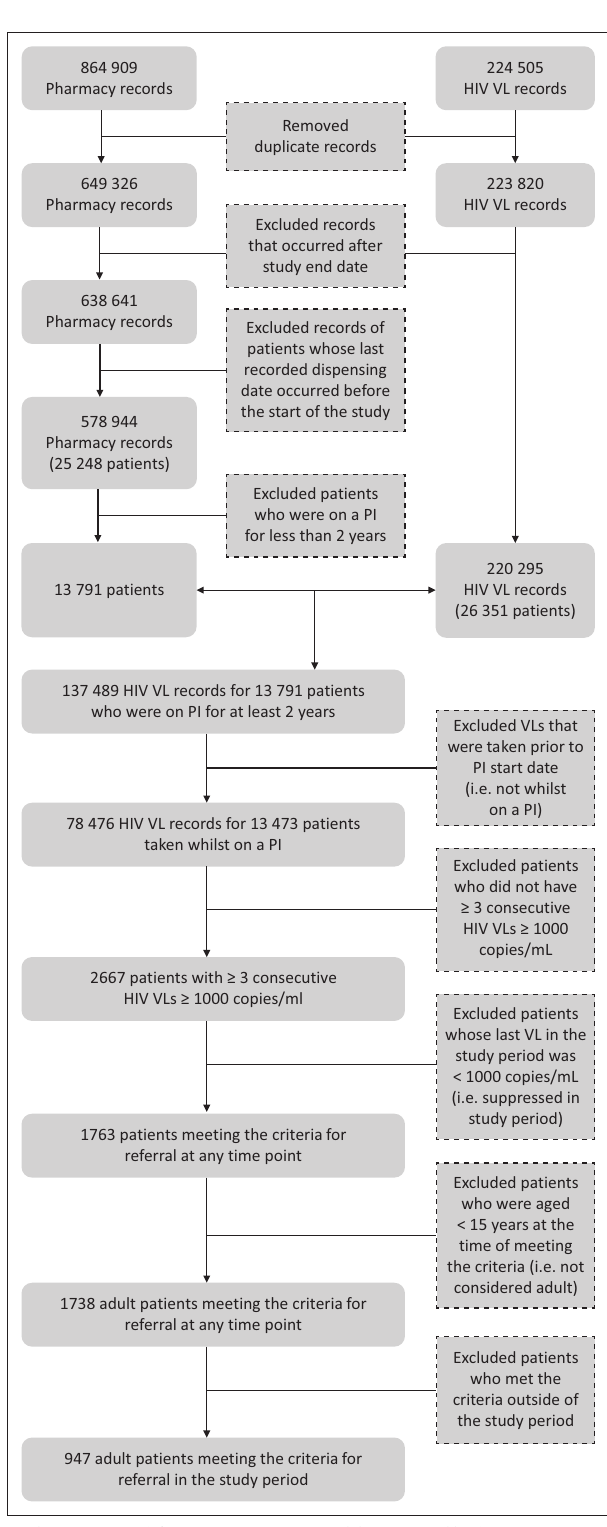
FIG URE 2: Estimating qualification for referral: Data cleaning and analysis